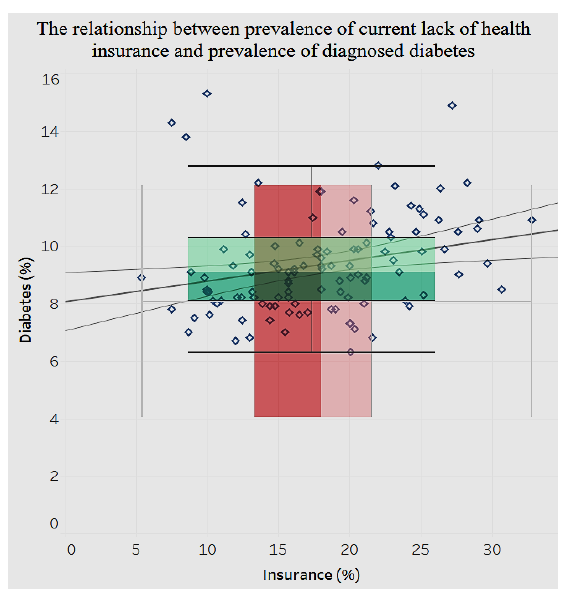
Figure 20. Current lack of health insurance by diagnosed